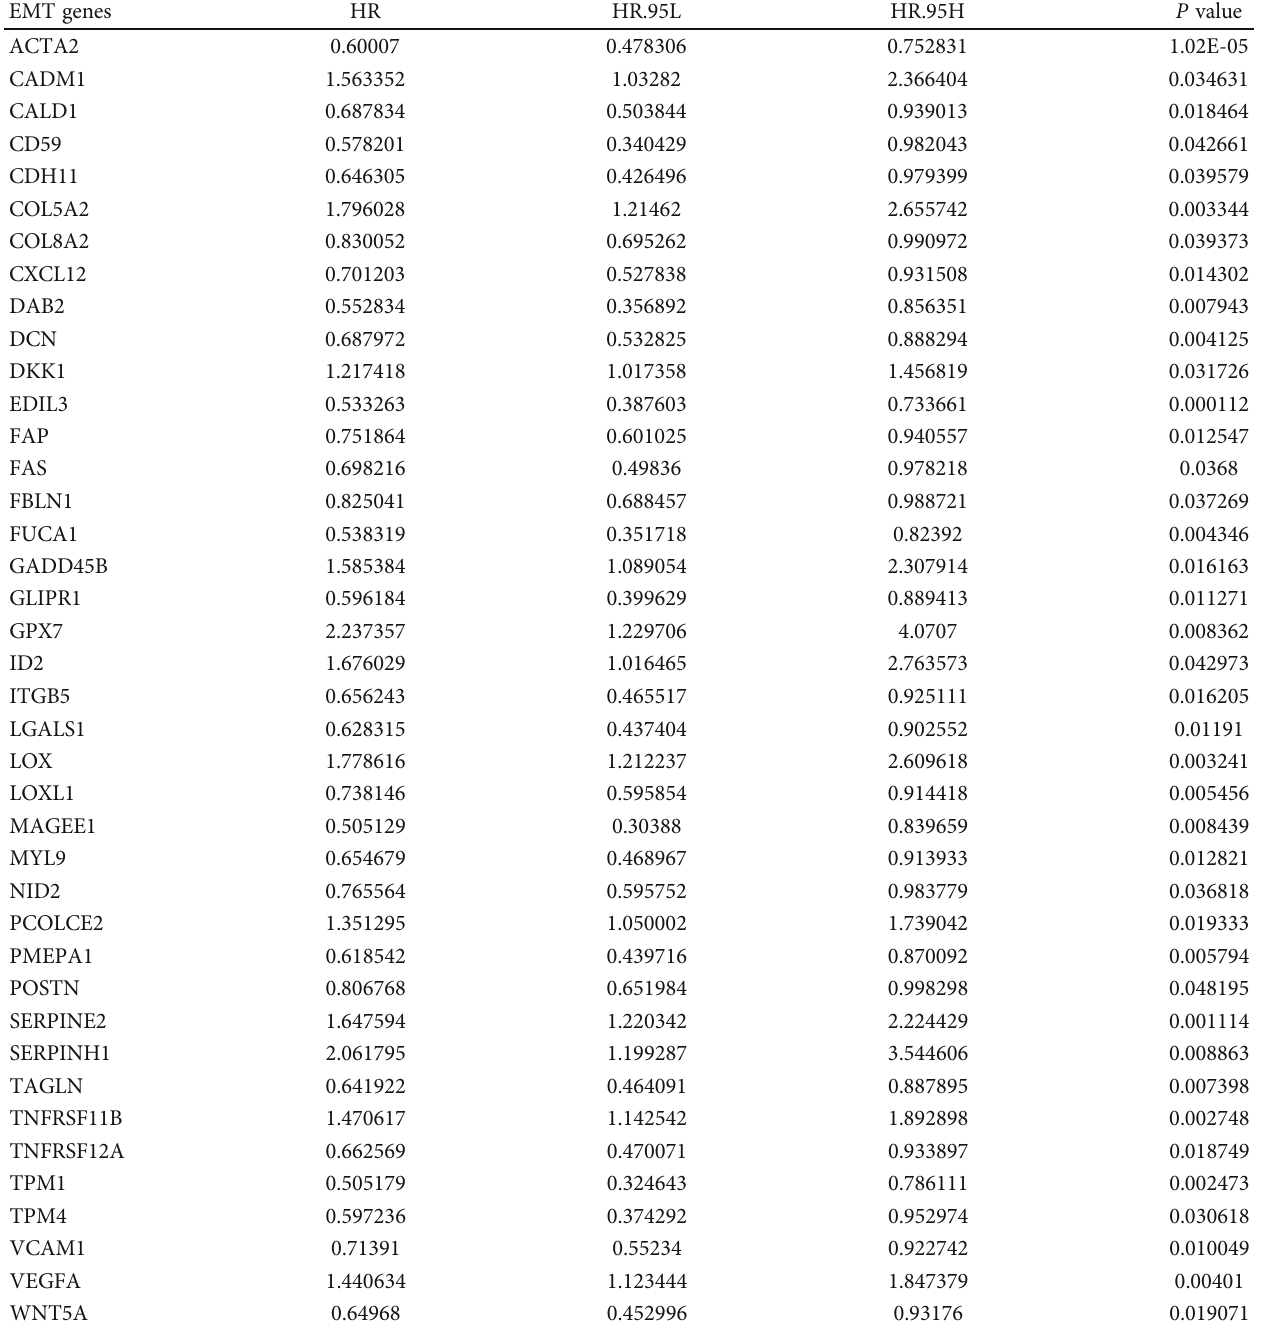
Table 1: Prognostic EMT genes of osteosarcoma in the TARGET